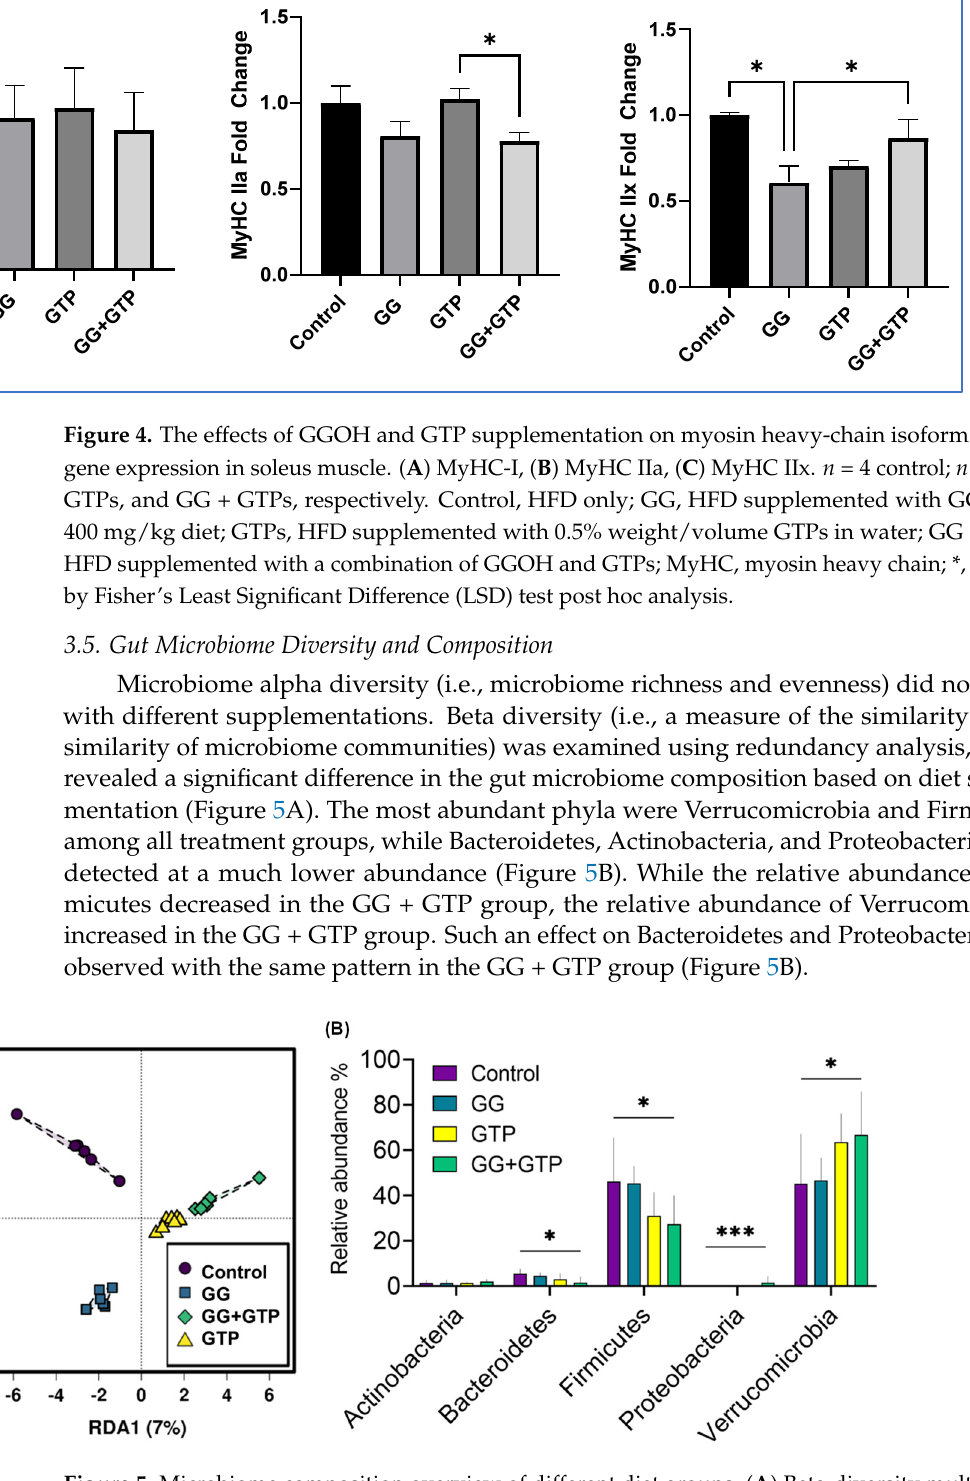
Figure 5. Microbiome composition overview of different diet groups. ( A ) Beta-diversity multivariate analysis using redundancy analysis (RDA). ( B ) Relative abundance differences in major phyla among diet groups. Control, HFD only; GG, HFD supplemented with GGOH in 400 mg/kg diet; GTPs, HFD supplemented with 0.5% weight/volume GTPs in water; GG + GTPs, HFD supplemented with a combination of GGOH and GTPs; * p < 0.05 and *** p < 0.001. Kruskal–Wallis test was performed followed by Dunn’s test.